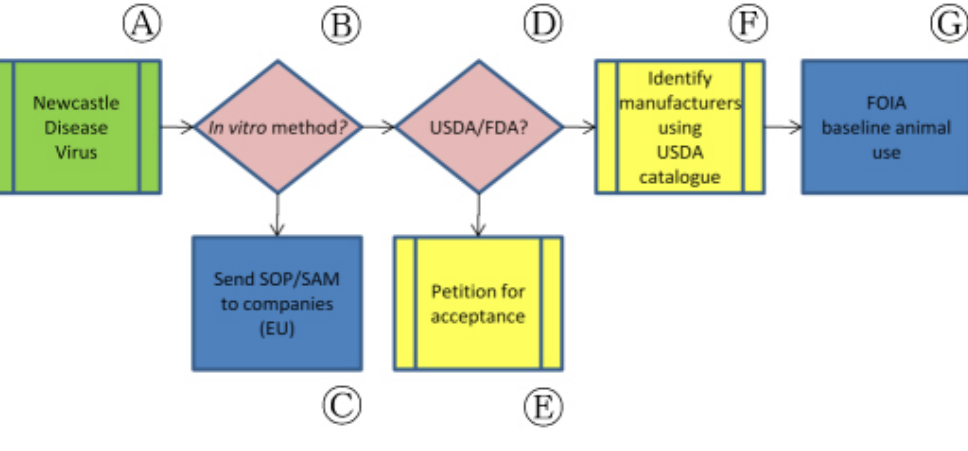
Figure 5. Application of bridging paradigm to NDV vaccine potency testing in the United